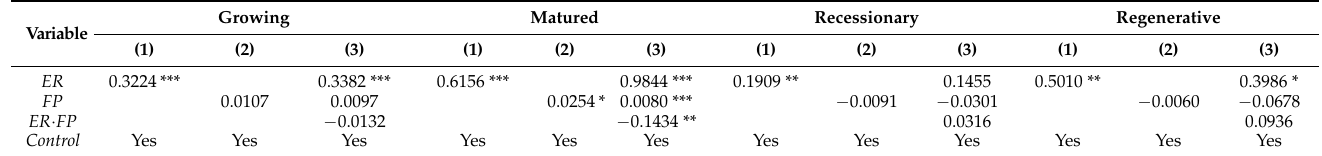
Table 5. Regression results by different economic development